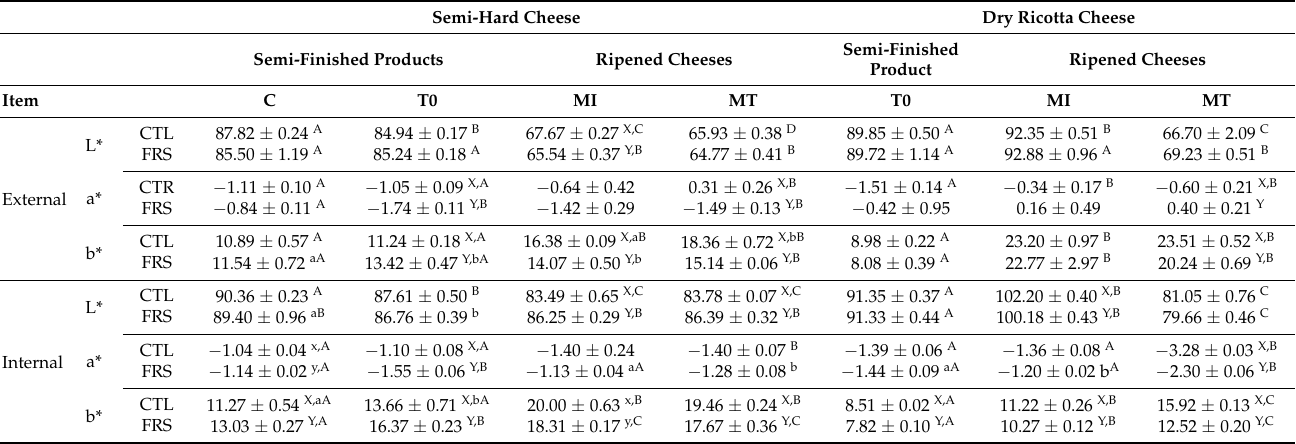
Table 4. Effects of feeding system and ripening time on internal and external color of semi-hard cheeses.